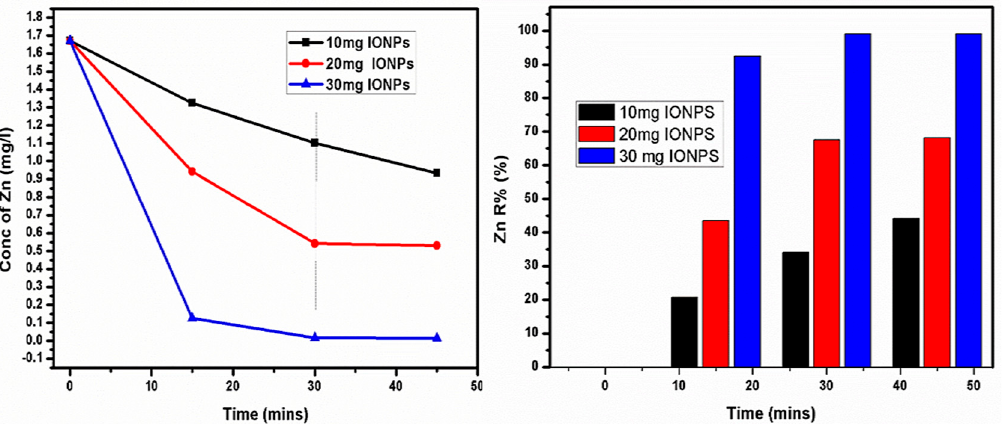
Figure 10. Removal of Zn using IONPs at different concentrations and their removal%.